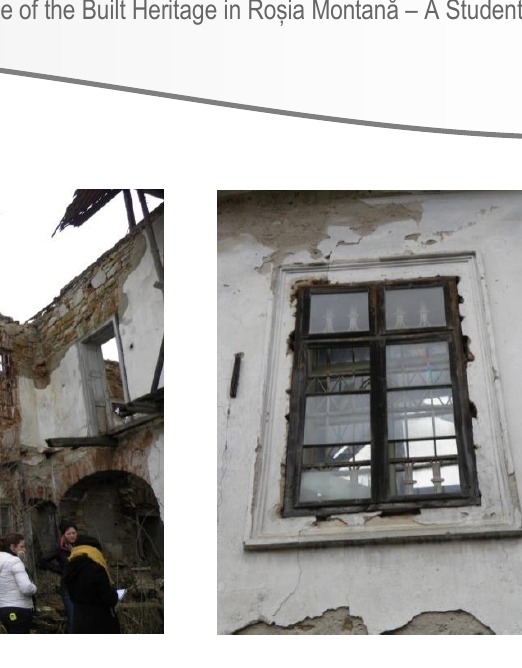
Figure 4: Reformed Parsonage courtyard view Figure 5: Window detail